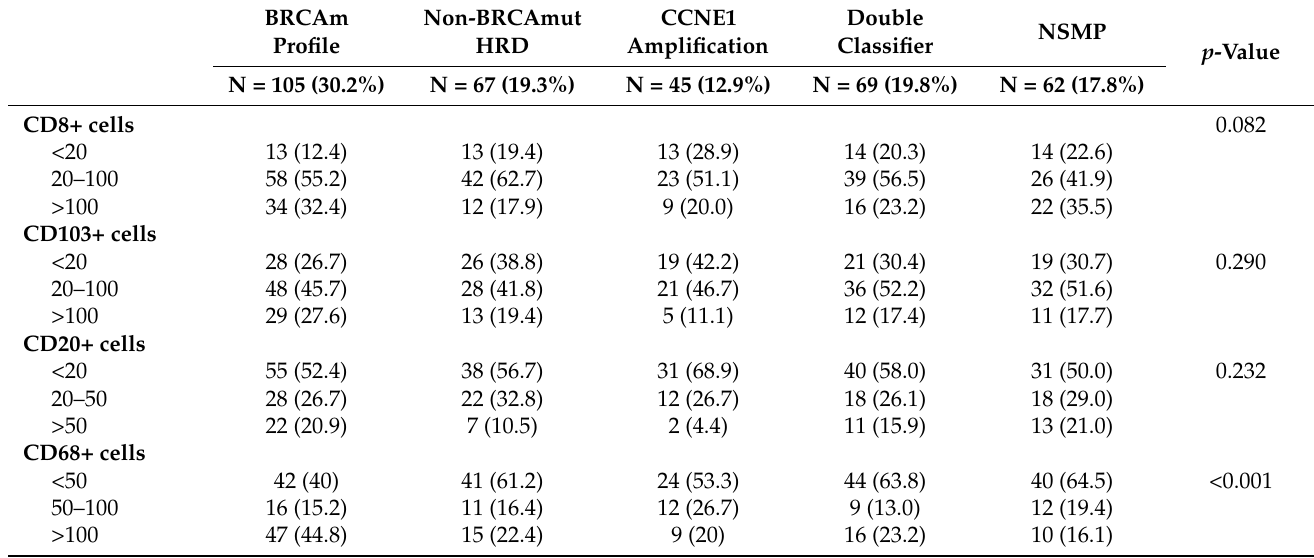
Table 2. Immune cell composition stratified by molecular